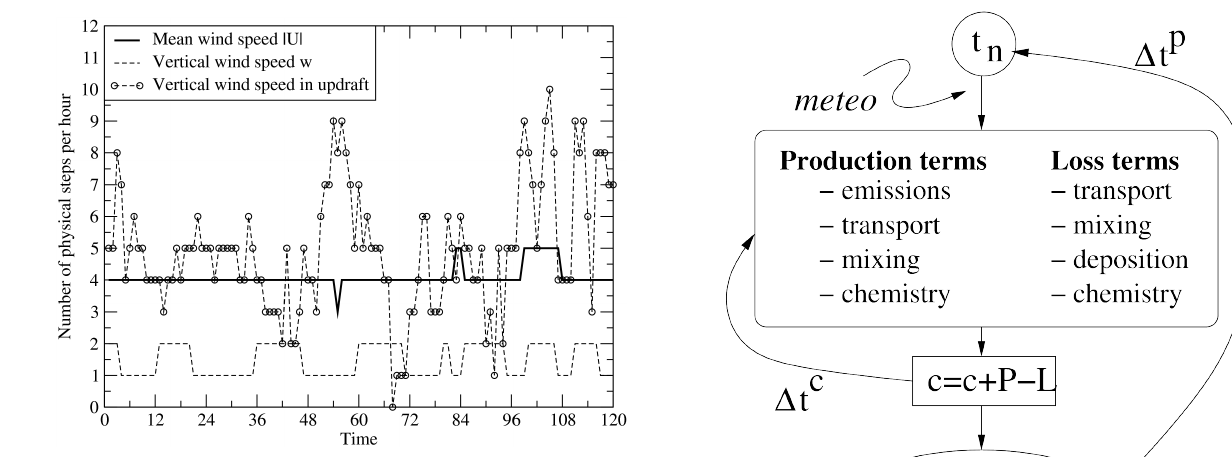
Fig. 3. Calculation of the number of integration steps per hour to respect the Courant–Friedrich–Levy (CFL) number over a complete 120h simulation. The CFL is estimated using three parameters: the mean wind speed | U | , the vertical wind speed in the environment w , and the vertical velocity in the updraft in case of active deep convection.